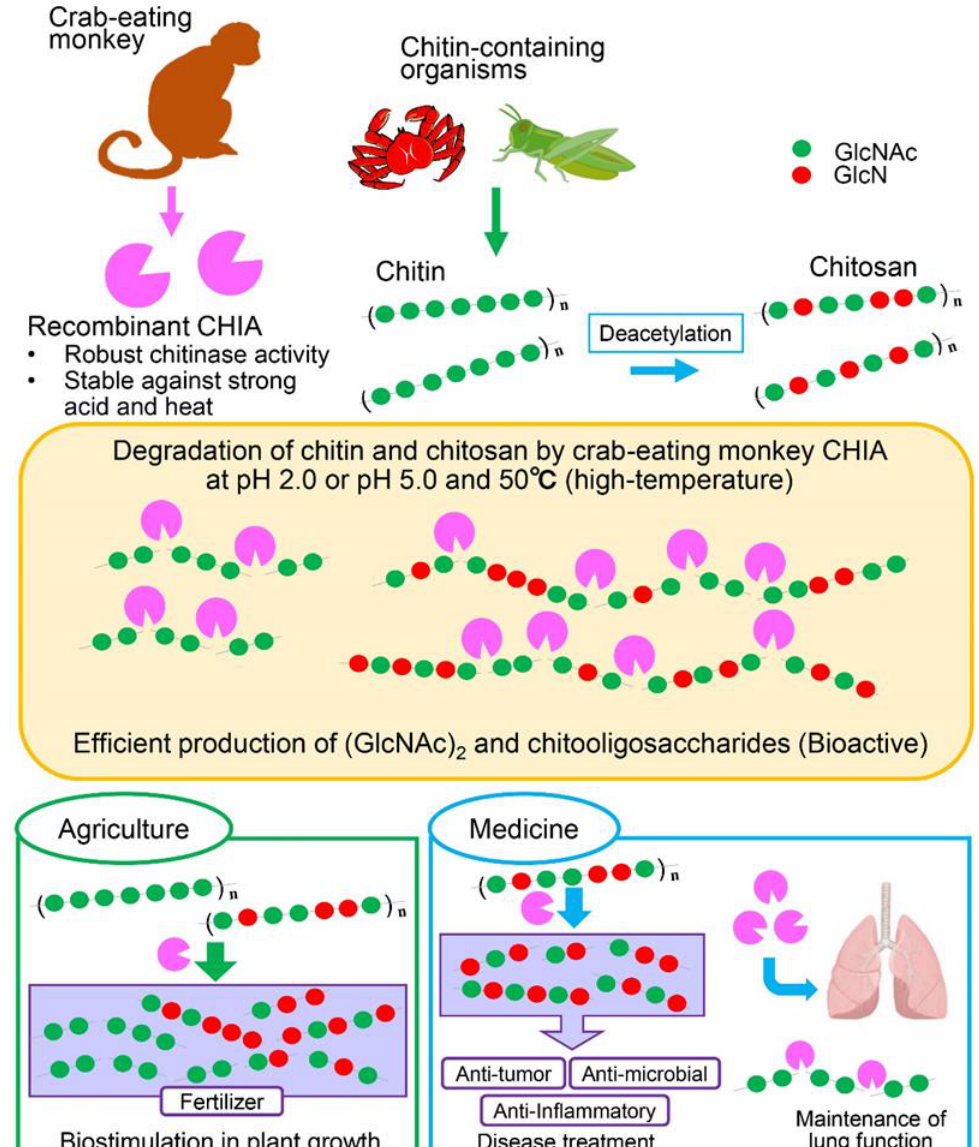
Figure 5. Efficient chitin and chitosan degradation by monkey CHIA at a high temperature (50 °C) produces different chitooligosaccharides. The higher temperature increased the efficiency of substrate degradation, with chitin and chitosan being processed to (GlcNAc) 2 and chitooligosaccharides with variable lengths, respectively. The crab-eating monkey CHIA has a promising potential for producing chitooligosaccharides for agricultural and biomedical purposes.